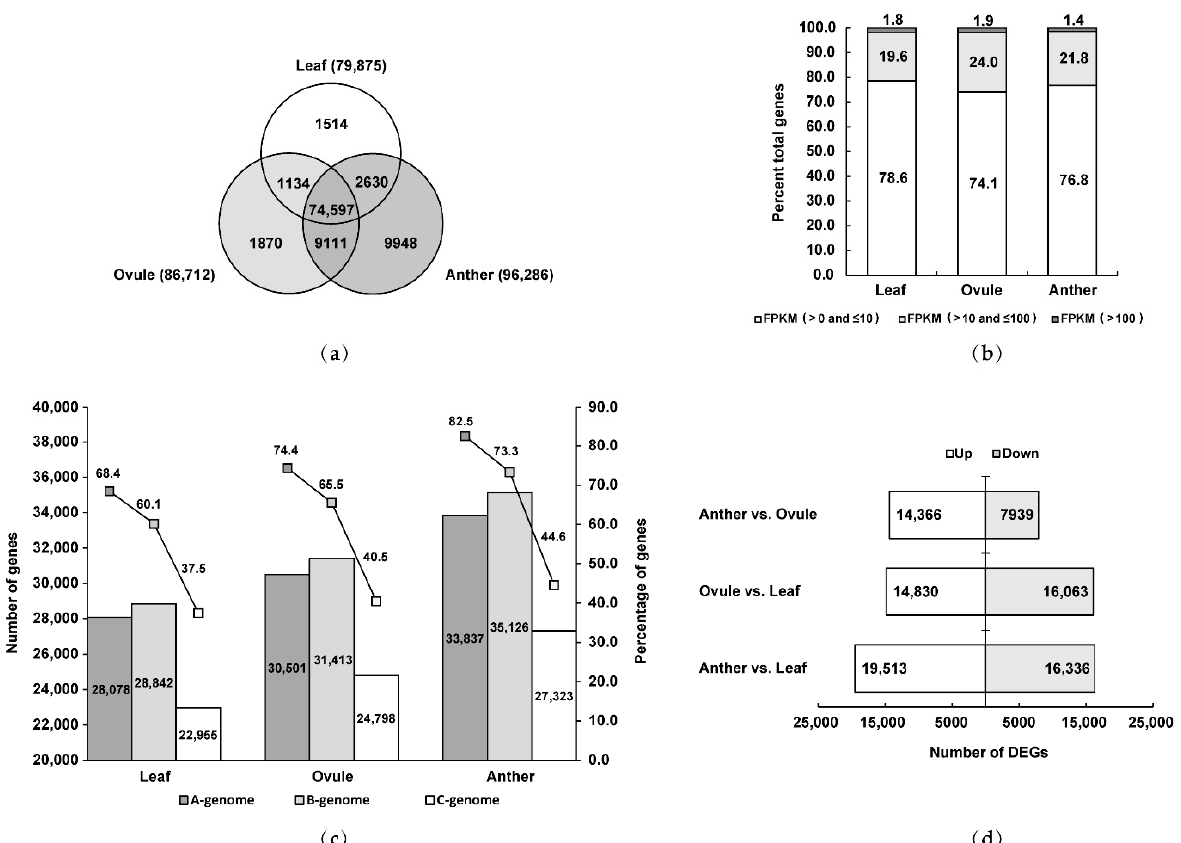
Figure 1. Overview of gene expression in Anther, Ovule and Leaf of Brassica allohexaploids: ( a ) Venn diagram showing the overlap between expressed genes in Anther, Ovule and Leaf; ( b ) distribution of FPKM range in Anther, Ovule and Leaf; ( c ) the number of genes from A, B and C-genomes in Anther, Ovule and Leaf and the proportion of genes in the reference genomes; and ( d ) results of pairwise differential expression analysis in Anther, Ovule and Leaf.